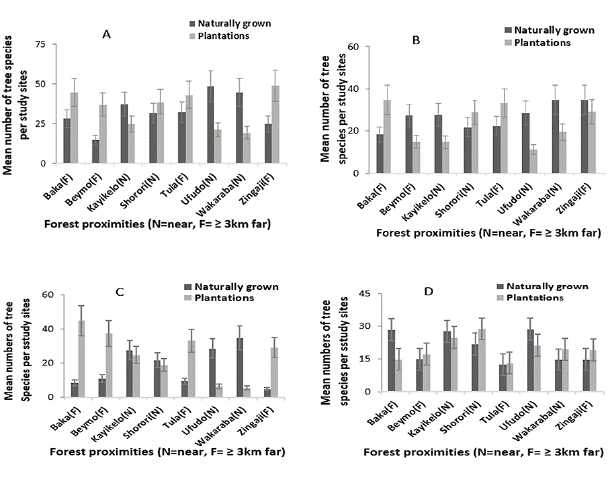
Fig. 4. Mean numbers of integrated tree and crop species at the study sites. The statistical interpretations of the patterns are found in the text. The sample size is found in Table